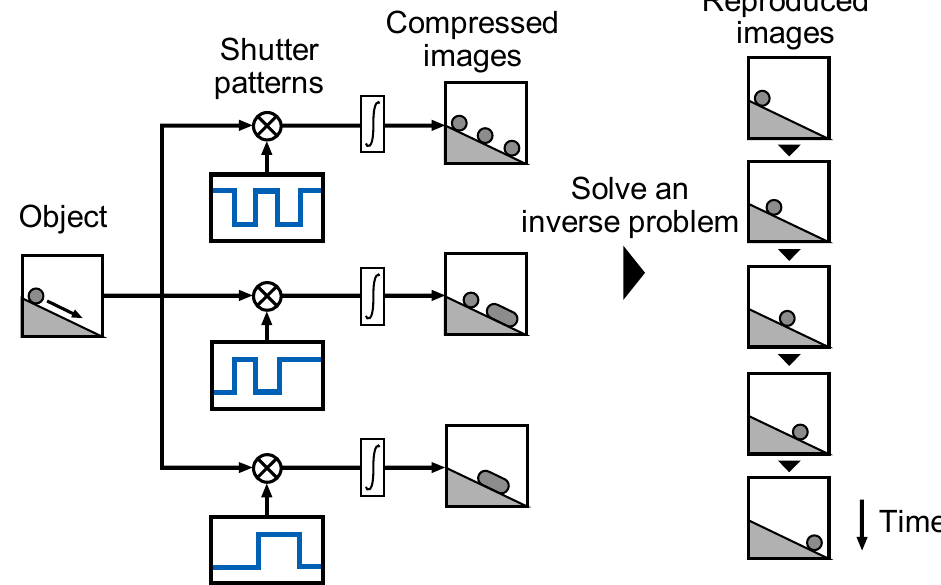
Figure 3. Image acquisition and reproduction flow of temporally compressive imaging. The object images are compressed in time with the temporal shutter patterns. Then, sequential images are reproduced by solving an inverse problem based on sparsity constraint.